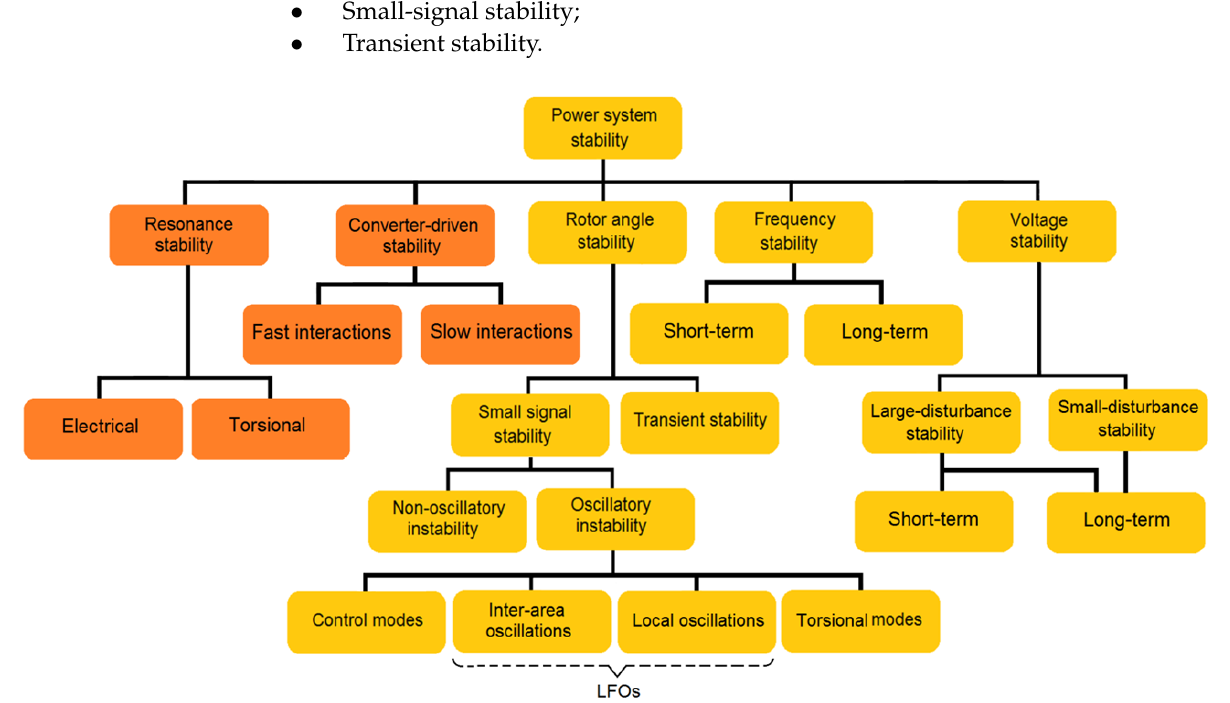
Figure 1. Power system stability classification.